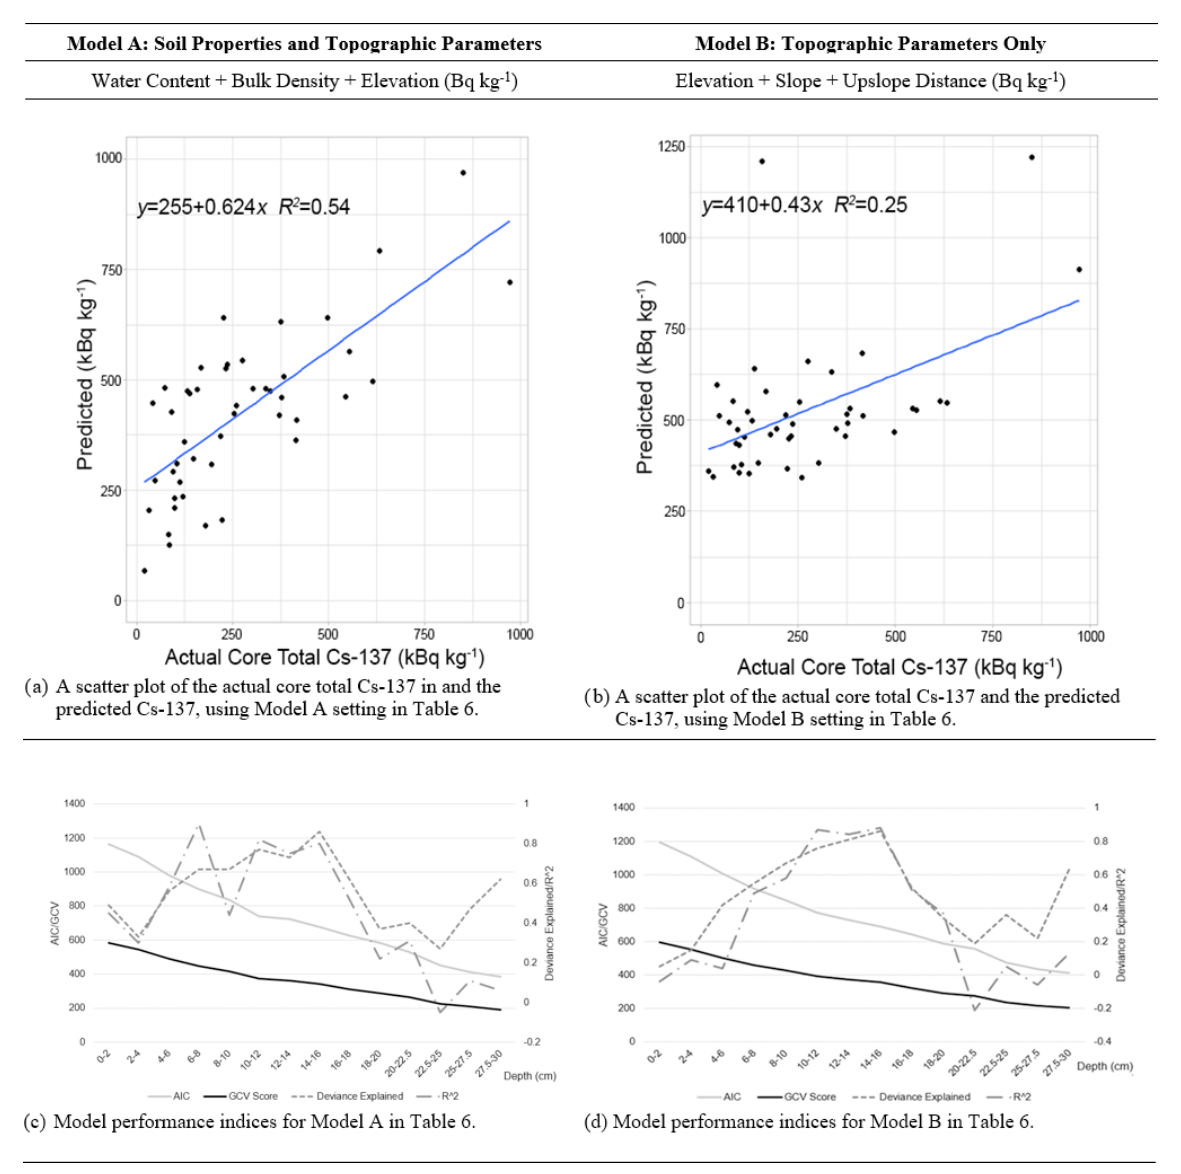
Figure 12. (a, b) Regression analysis of actual and predicted Cs-137 activities. (c, d) Model fit diagnosis results of the best-performing models (light gray: AIC; black: GCV score; dashed: deviance-explained percentage: loosely dash-dotted: R 2 ). Higher deviance-explanation percentages and R 2 values indicate how well the model explained, or approximated, the real data points. Lower AIC indicates a good model with less information loss (parsimony), and lower GCV suggests a good model with a smaller prediction error (Hastie et al., 2009; Wood,